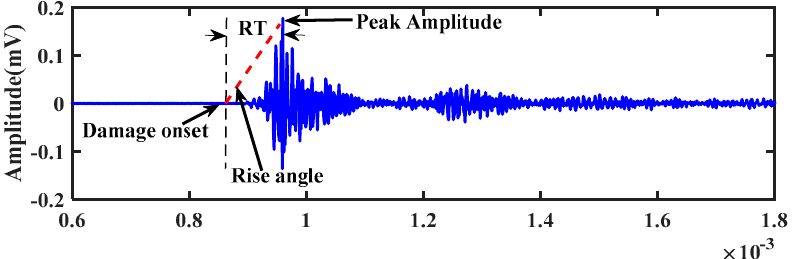
Figure 8. The rise angle produced due the crack development on the spherical tank .